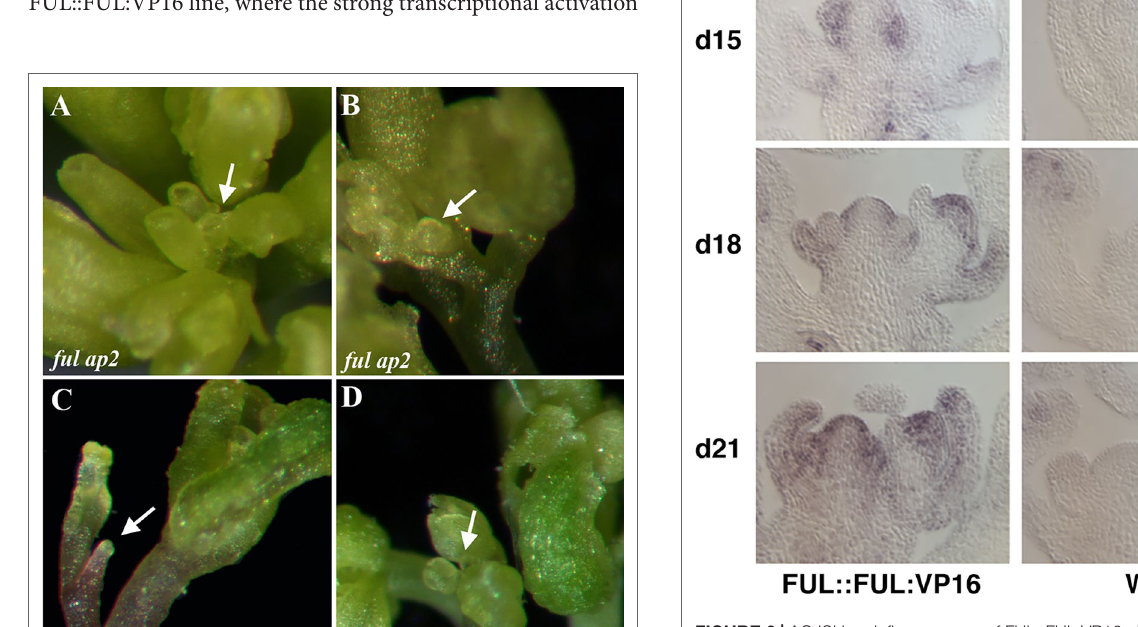
FIgURe 6 | AG ISH on inflorescences of FUL::FUL:VP16 plants. AG expression was detected by ISH on FUL::FUL:VP16 (left) and wild-type (right) plants at early stages of inflorescence development. Samples were collected 15, 18, and 21 days after germination. While in the wild-type plants AG expression was only detected in the center of floral meristems, in FUL::FUL:VP16 plants AG expression was detected ectopically in the periphery of the shoot apical meristem (SAM) at 18 days after germination (approx. 1 week after floral transition), being present throughout the SAM 21 days after germination (approx. 2 weeks after floral